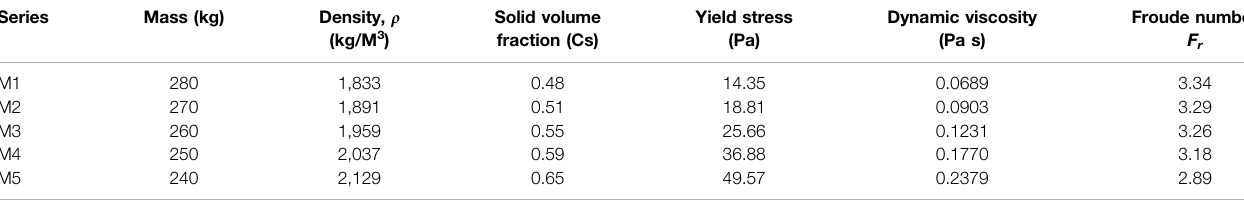
TABLE 1 | Characteristic parameters of debris fl ow samples.